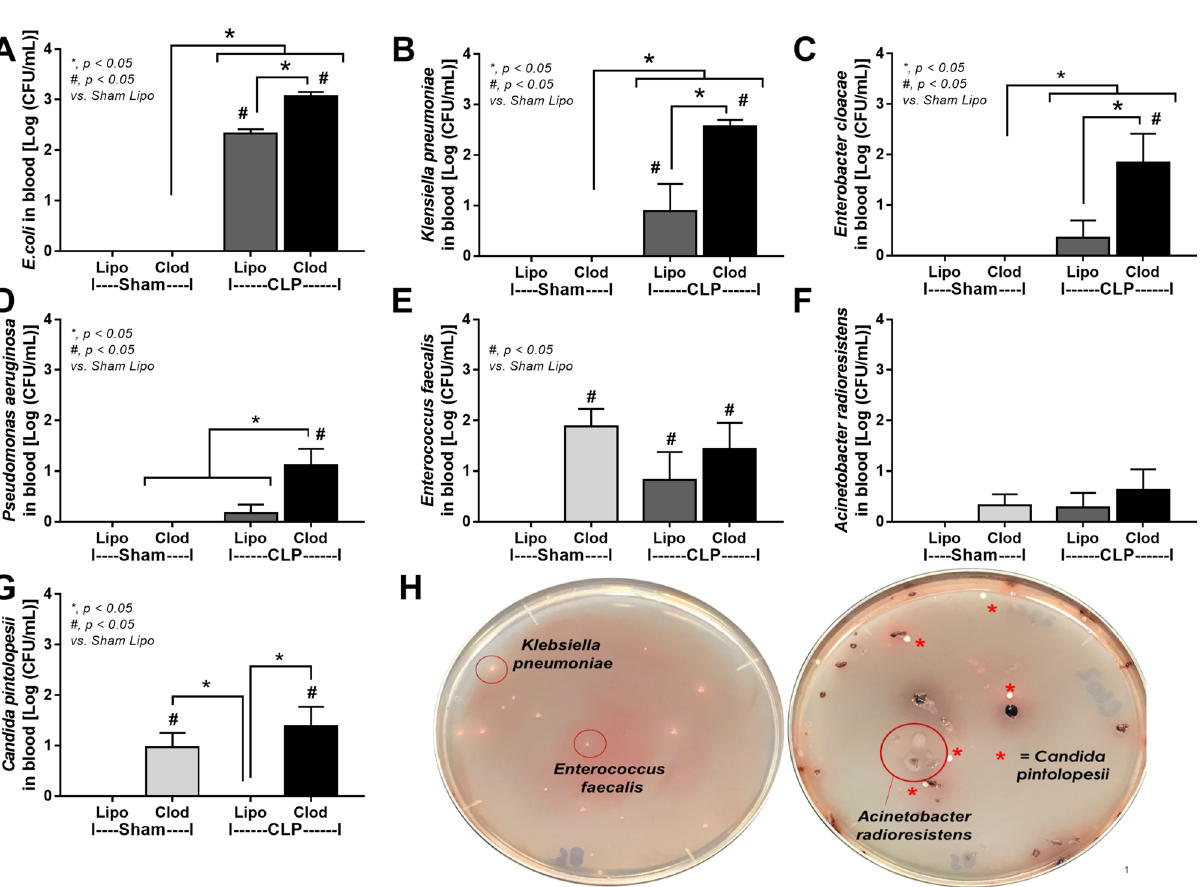
Figure 6. Characteristics of mice with liposomal clodronate (Clod) or liposome control (Lipo) after sham or cecal ligation and puncture (CLP) surgery as evaluated by organism identification (bacteria and fungi) from colony characteristics in blood agar using mass spectrometry analysis ( A – G ) are demonstrated (n = 6–8/group). The representative of the blood agar culture plates of CLP mice ( H ) demonstrated the plate with different bacterial colonies without fungal colonies (left side) and the mixed bacterial and fungal colonies (right side). The red circles identify bacterial colonies (using mass spectrometry analysis). The star symbols indicate the colonies of Candida pintolopesii